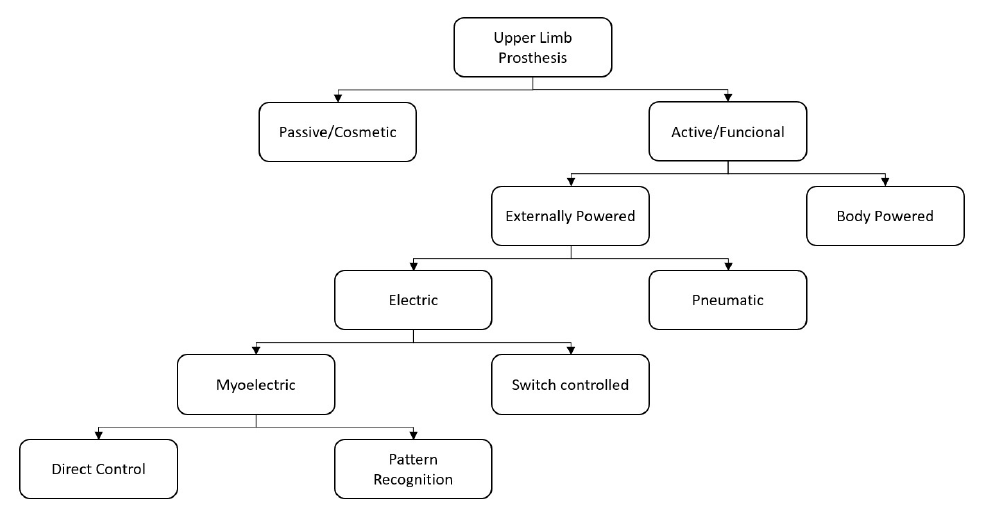
Figure 1. A Block diagram describing the types of Upper Limb Prostheses and control